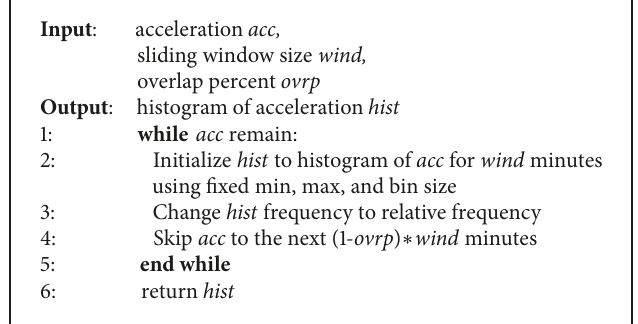
Algorithm 2: Feature extraction algorithm.